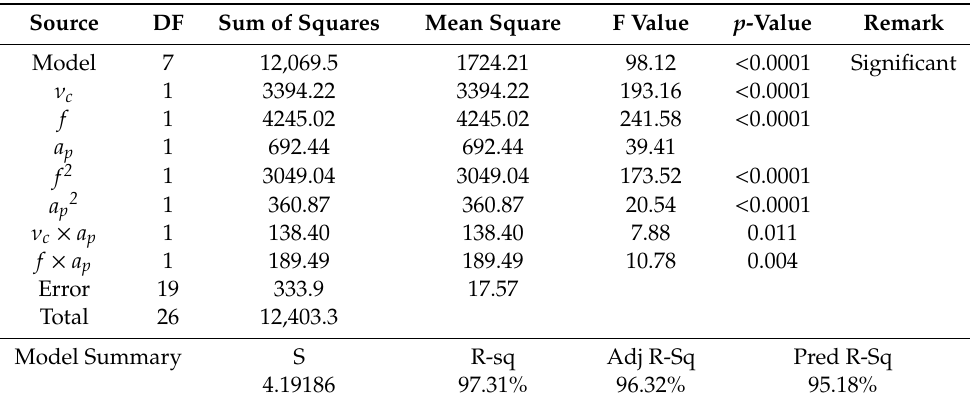
Table 8. ANOVA and R-squared for microhardness ( HV